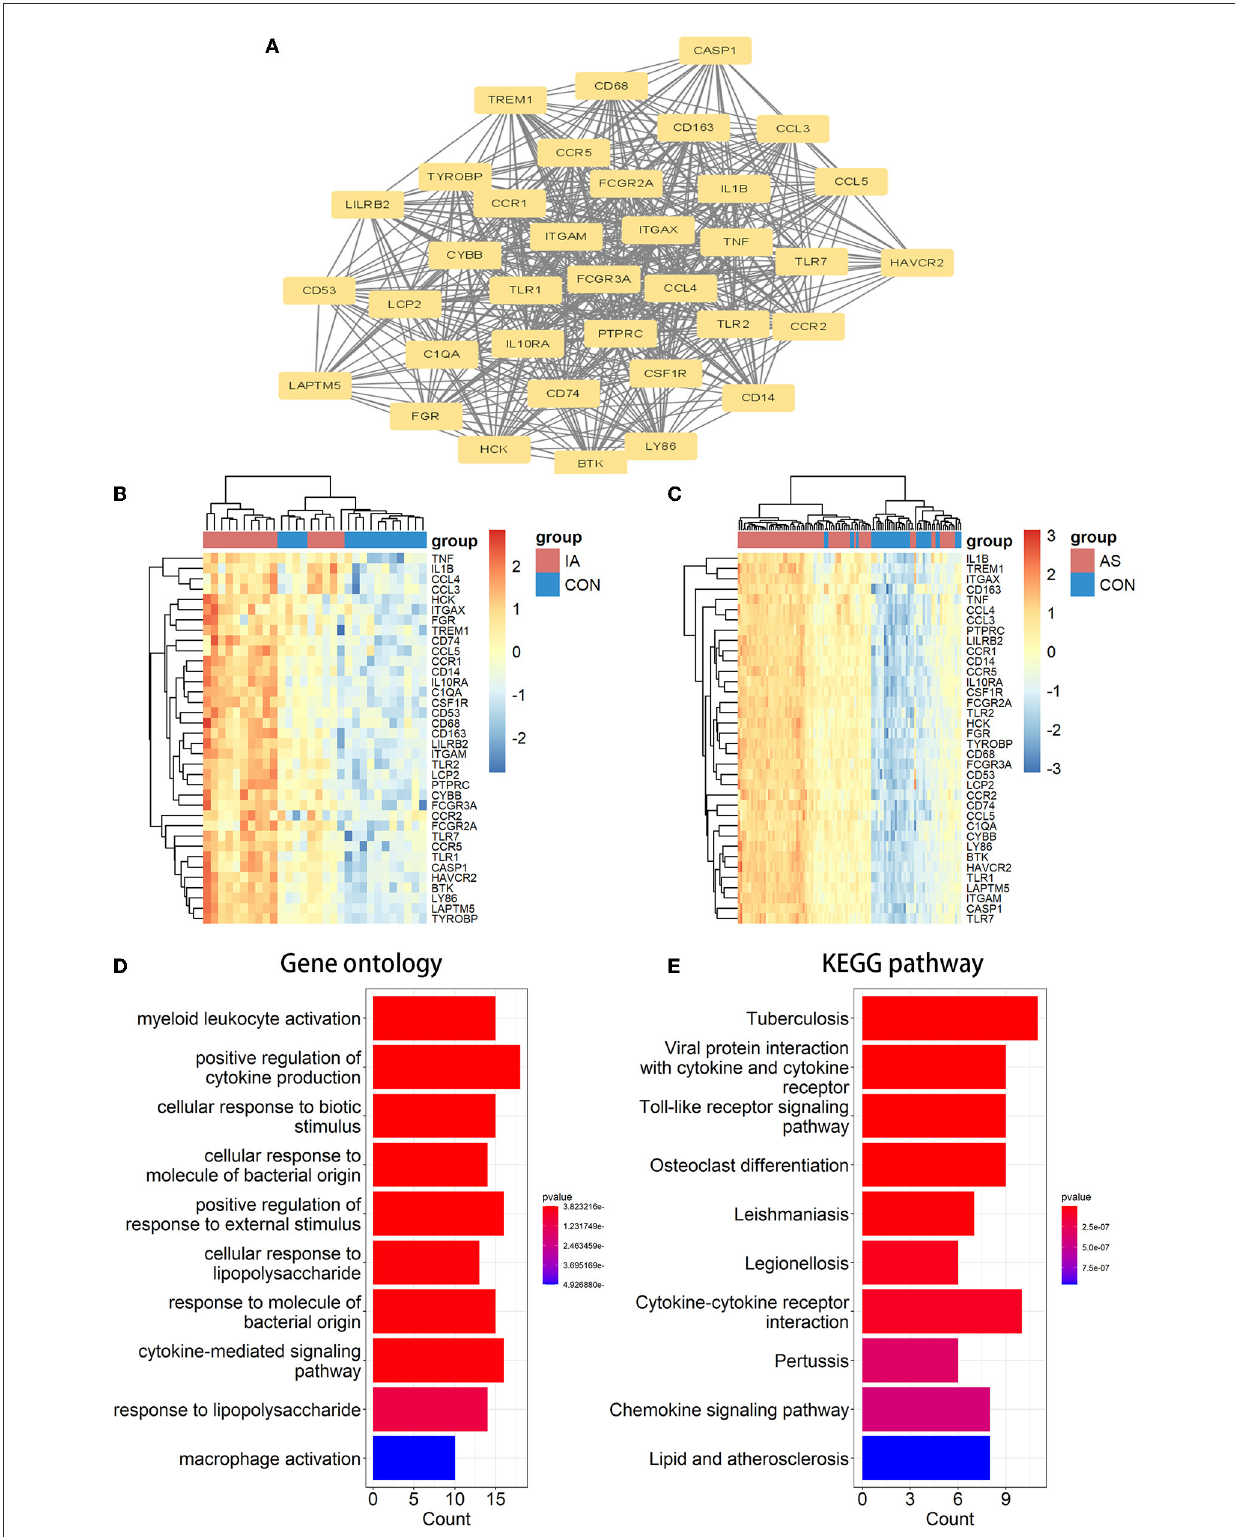
FIGURE4 MCODE-identified genes module and corresponding enrichment analysis results. (A) One essential module of gene clustering. (B, C) Distribution of gene expression levels in the module. (D, E) The genes module underwent GO and KEGG analysis. It was deemed significant if the adjusted P -value <